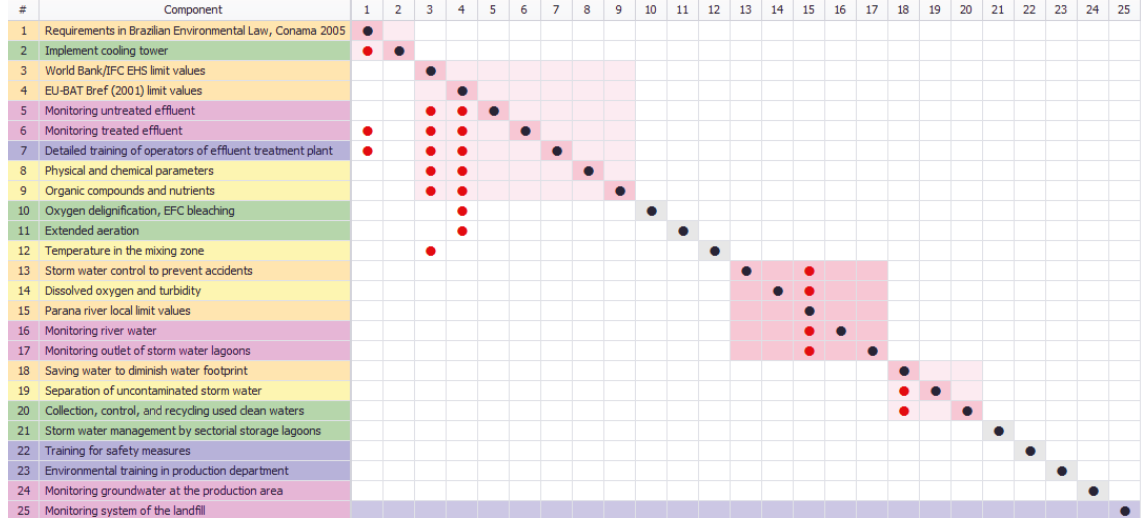
Figure 11: Partitioned